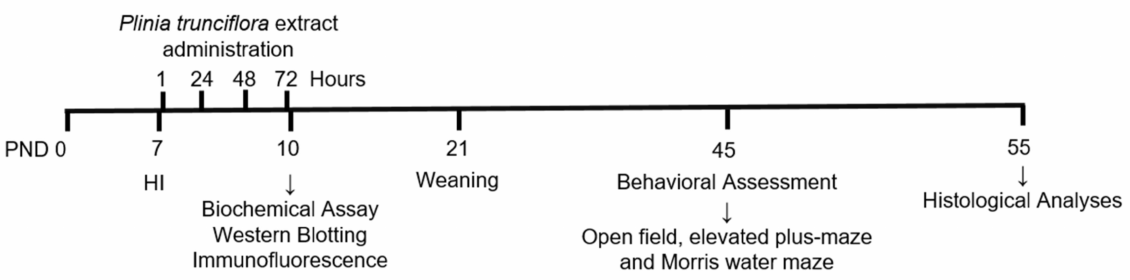
Figure 1. Experimental Design. From postnatal to adulthood in Wistar rats. PND: postnatal day; HI: